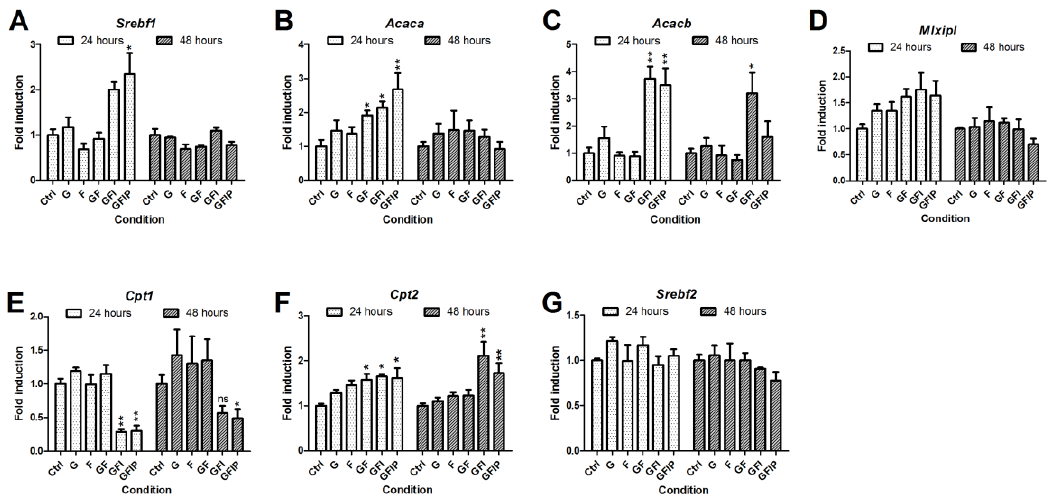
Figure 3. Relative mRNA expression of genes related to lipid metabolism, specifically ( A ) Srebf1 , ( B ) Acaca , ( C ) Acacb , ( D ) Mlxipl , ( E ) Cpt1 , ( F ) Cpt2 , and ( G ) Srebf2 . Values are displayed as mean fold